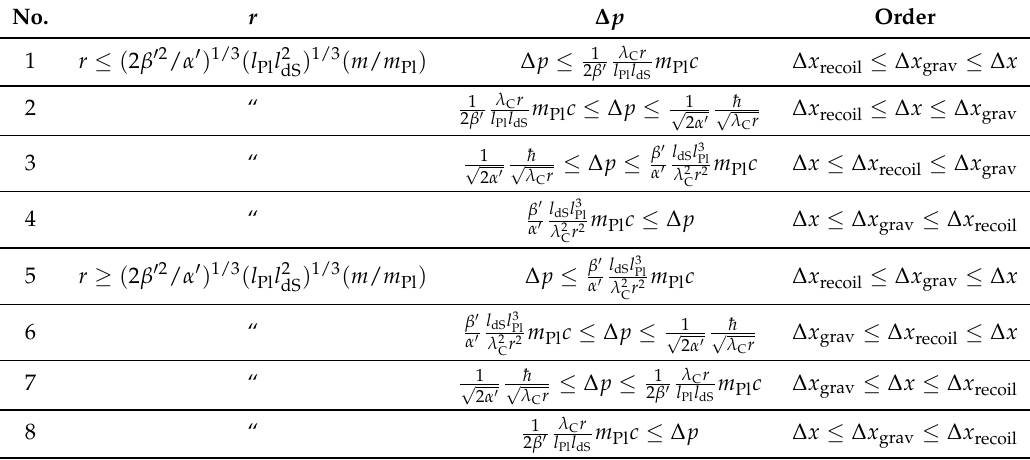
Table 1. Relative magnitudes of the three contributions to the total positional